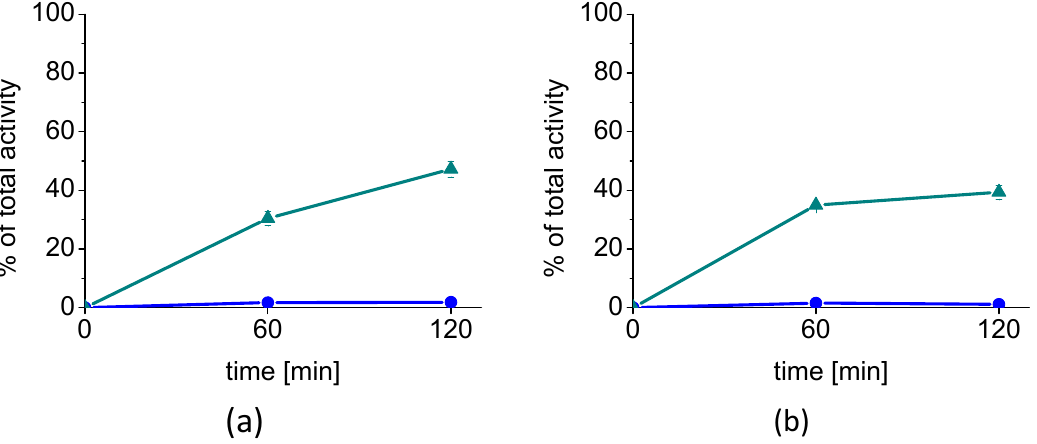
Figure 4. Cell internalization of [ 68 Ga]Ga-DOTA-MGS8 in ( a ) A431-CCK2R cells and ( b ) AR42J cells after 1 and 2 h incubation ( n = 3) ( ▲ internalized, ● membrane-bound). When considering the cell-associated radioactivity (internalized plus membrane- bound fraction), more than 94–96% of the radioligand was internalized by A431-CCK2R cells and 96–97% by AR42J cells in agreement with an agonist-induced receptor internali- zation (see Figure 5).